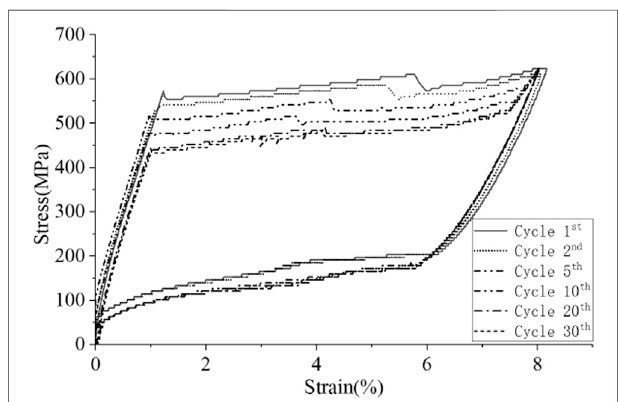
FIGURE 2 | The hysteretic curves of various cycles.